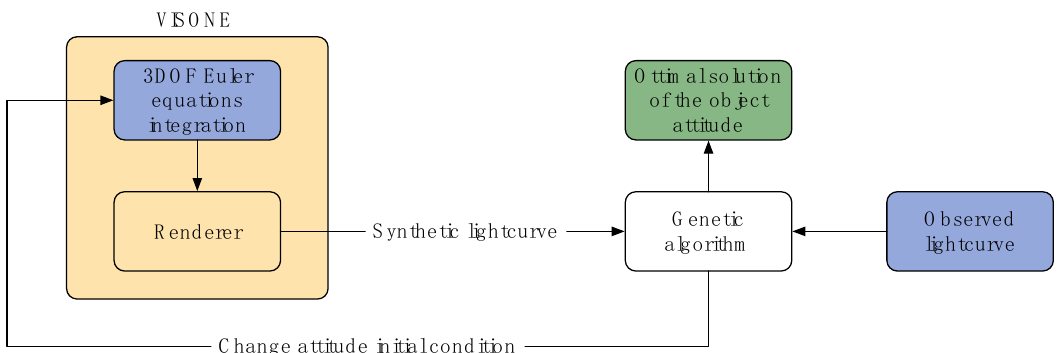
Figure 19. Optimization architecture—the scheme depicts how the proposed method finds the attitude is shown. The genetic algorithm uses the Equation (5) to compare the observed light-curve and the synthetic one. Then, the genetic algorithm changes the initial attitude parameters accordantly, in order to create a new synthetic light-curve. This process is repeated until the best synthetic attitude is found i.e., the presumable object attitude.